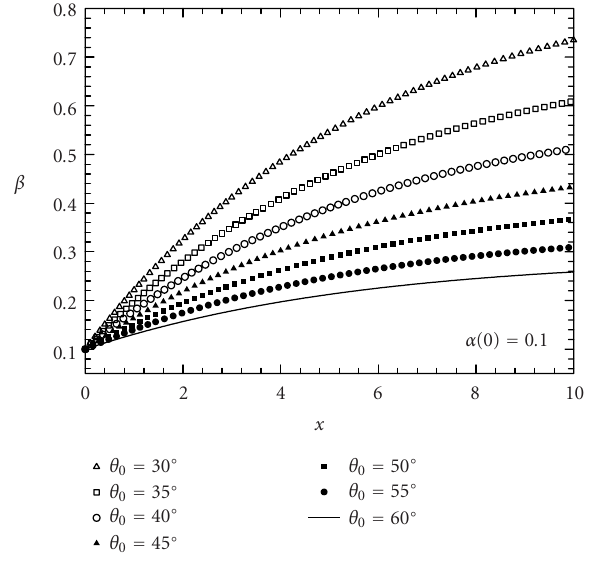
Figure 11: The predicted outlet size of distorted region versus θ 0 with smaller inlet size of distorted region of 0 . 1.